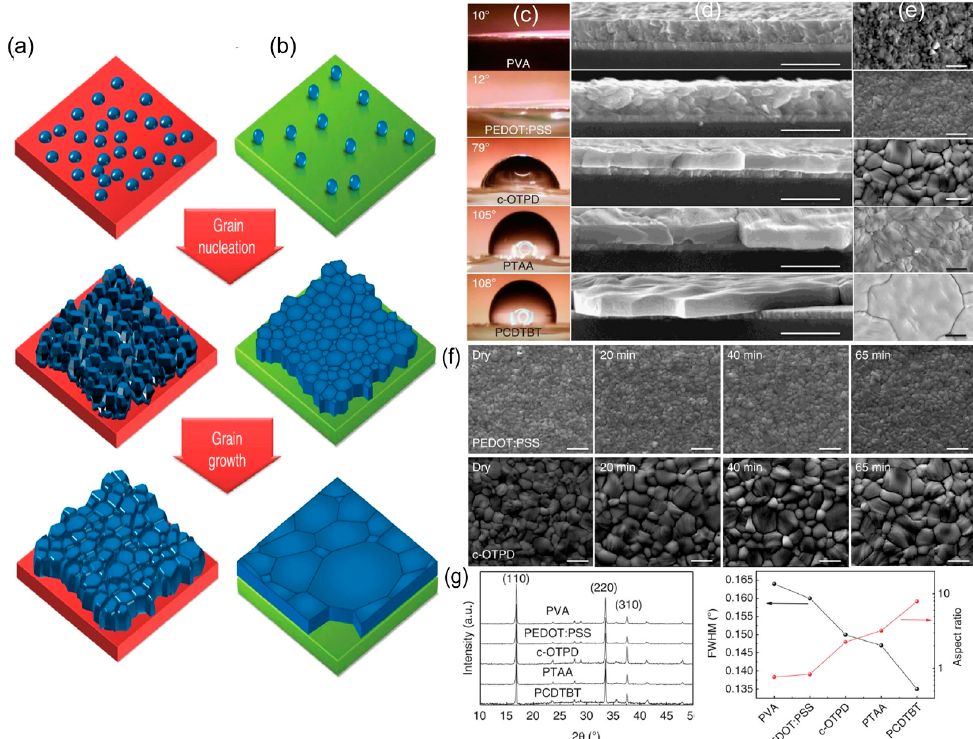
Figure 2. Schematic illustrations of nucleation and grain growth on ( a ) hydrophilic and ( b ) hydrophobic HTLs; ( c ) phenomena of contact angles of water with different HTLs; ( d ) cross-section and top-view SEM images with scale bars, 1 µ m; ( e ) top-view SEM images of CH 3 NH 3 PbI 3 with PEDOT:PSS and c-OTPD as HTLs after drying and with different annealing times (scale bar 1 µ m); ( f ) top-view SEM images of PEDOT:PSS and c-OTPD with different annealing time ( g ) X-ray diffraction patterns of the CH 3 NH 3 PbI 3 perovskites grown on different charge transport layers, and their full-width at half-maximum for the (110) peak (black curve) and the aspect ratio of the average grain size to the thickness [68]. Reprinted with permission.